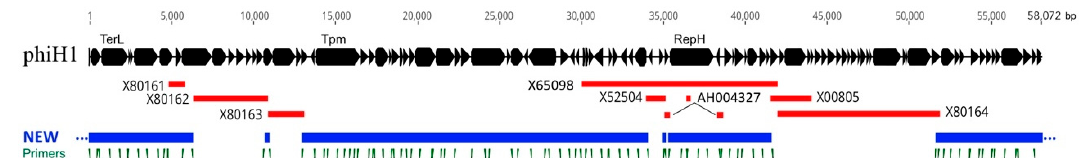
Figure 1. Diagram of the phiH1 genome with lines below showing regions previously sequenced (red) along with their database accessions. The blue lines (NEW) indicate regions sequenced in the present study by Sanger sequencing. Tick marks (dark green) below the blue lines show the positions of oligonucleotide primers used for PCR and primer-walking. Dots at the right and left contig ends indicate sequence continuity between them. Scale bar at top shows position in bp.